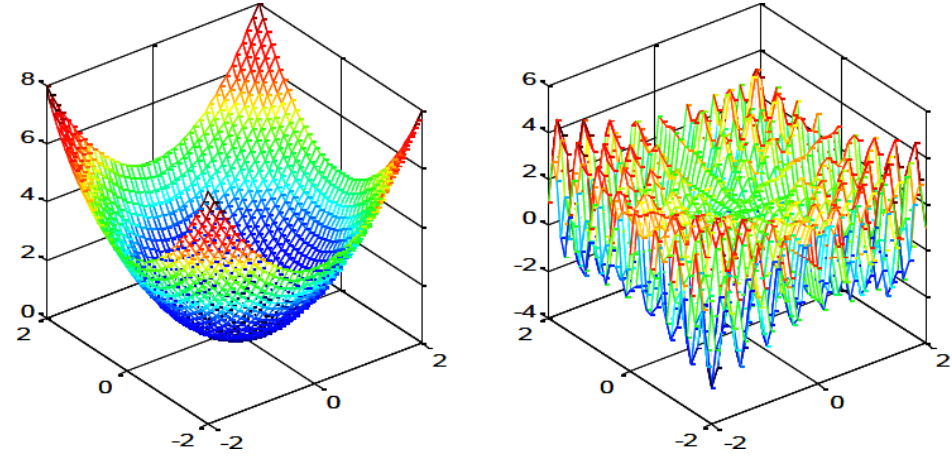
Figure 1: Representation of Uni-model and Multi-model error